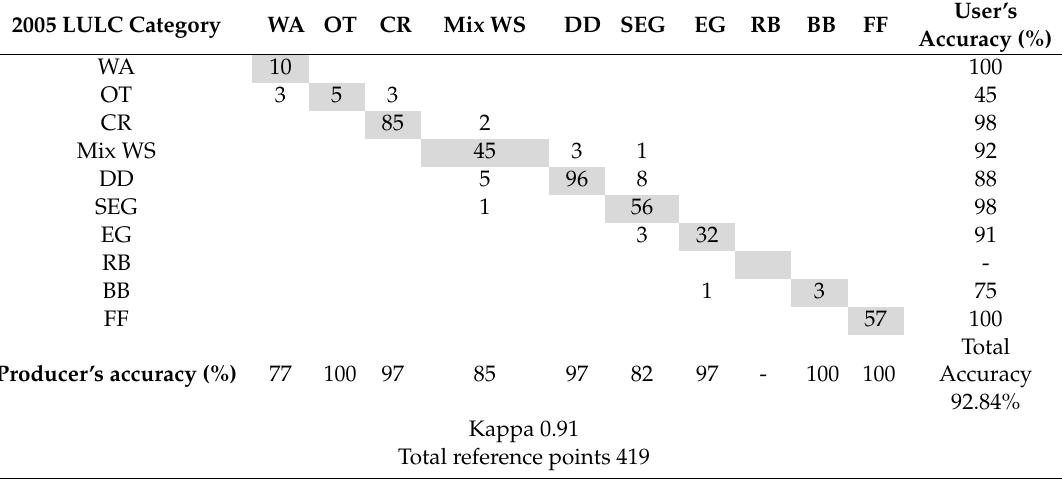
Table A4. Results of the accuracy assessment of the PBTC land cover map for 2005.